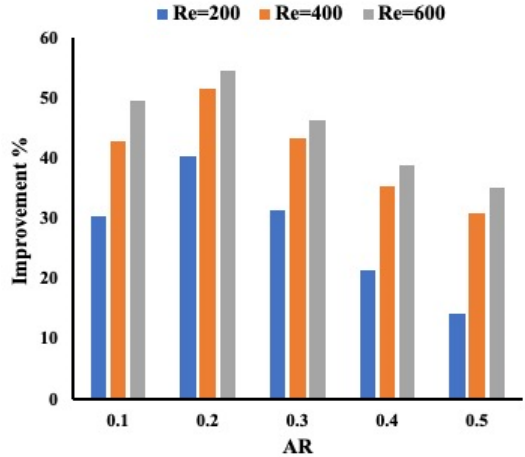
Figure 10. Performance evaluation criteria improvement.